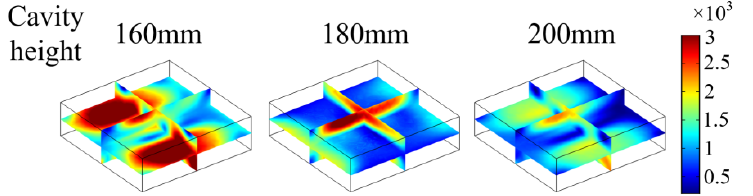
Figure 15. Electric field distribution of the potato at different cavity heights. (unit: V/m).